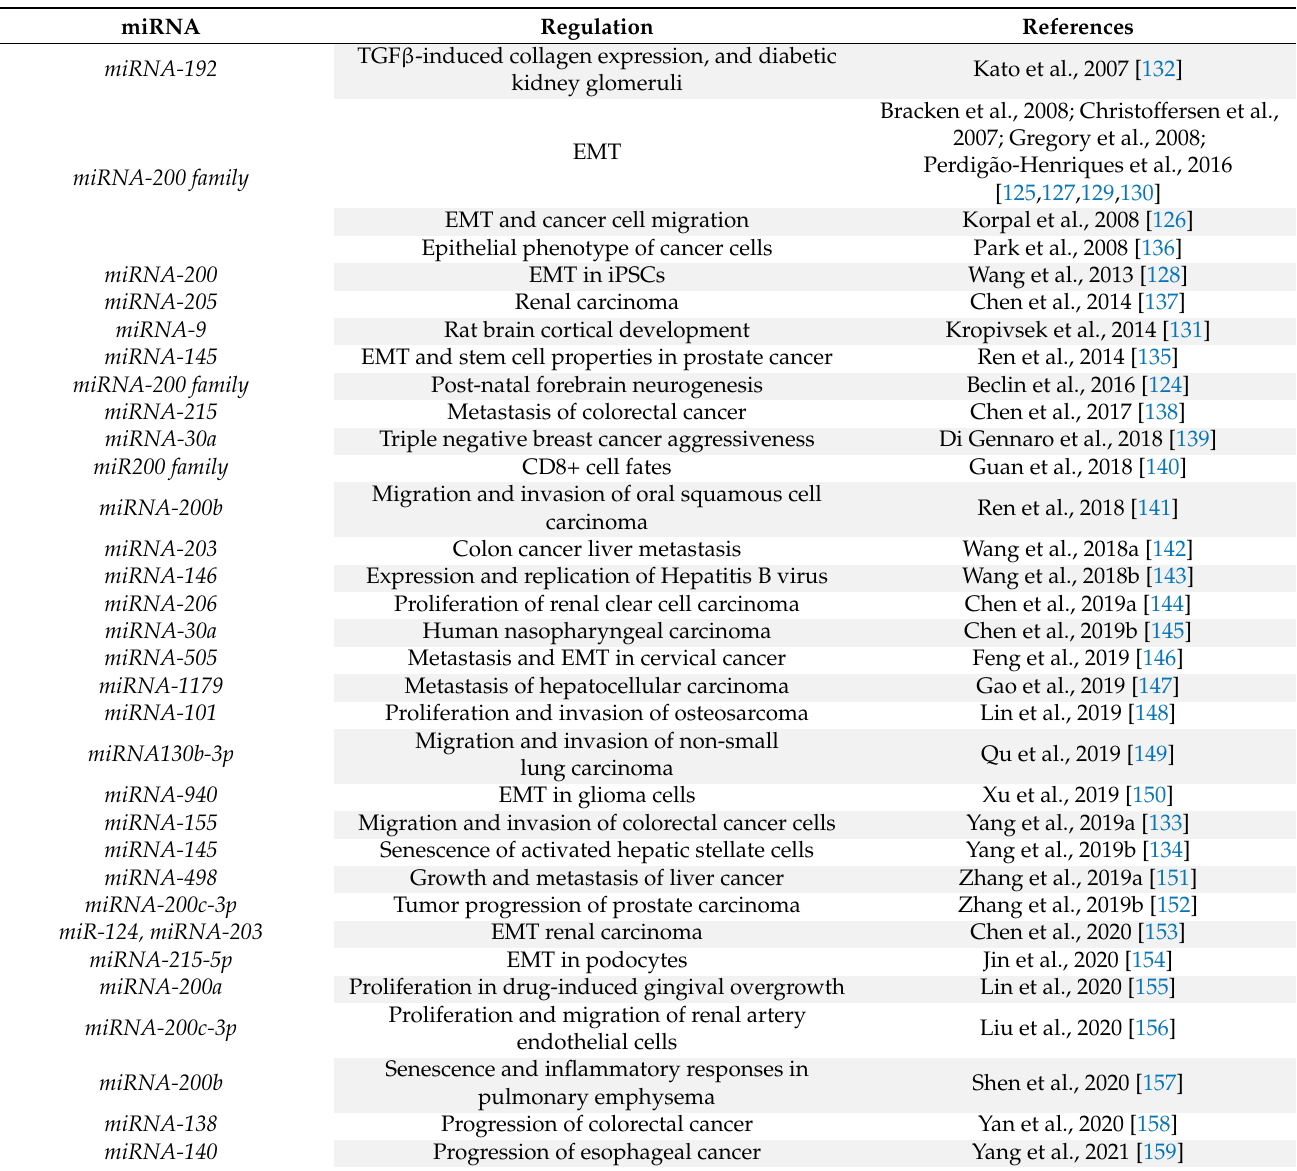
Table 3. ZEB2 associated